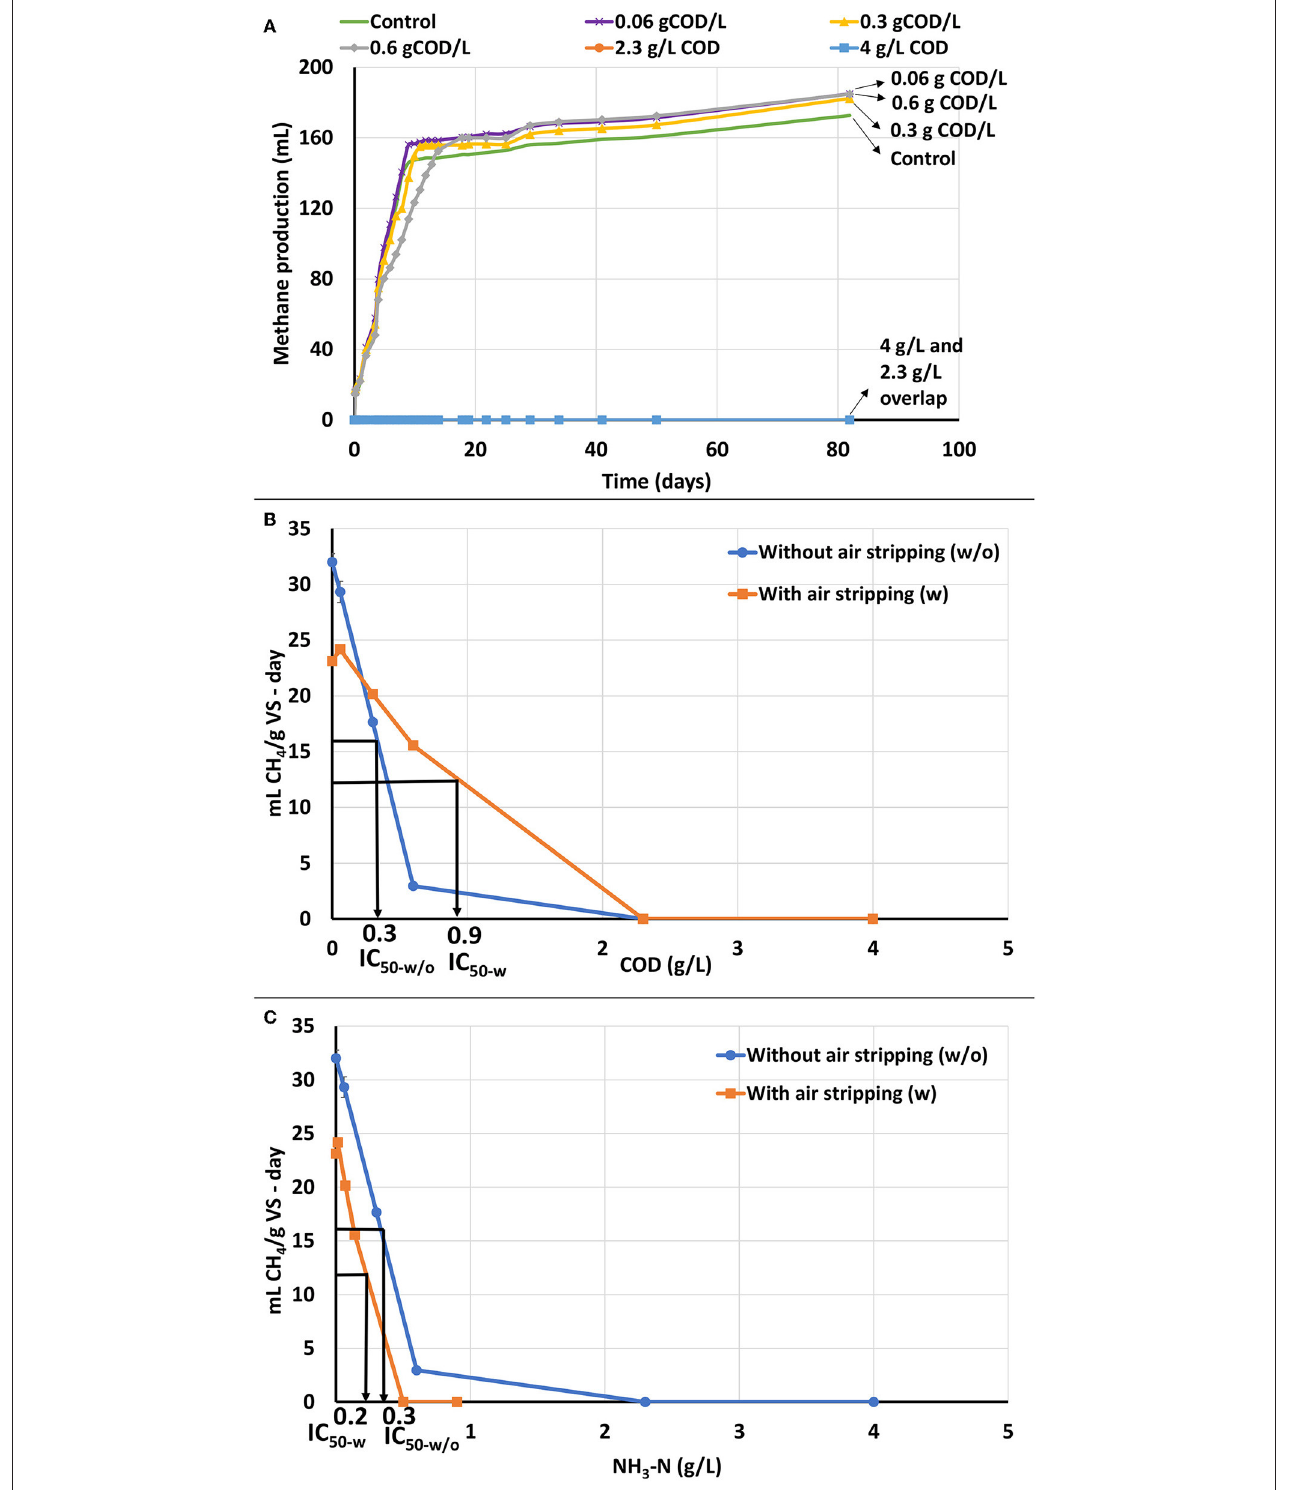
FIGURE 3 | ATA results on catalyzed APL with air stripping. Error bars represent standard deviation among duplicates. (A) Cumulative methane production of catalyzed APL with air stripping at different concentrations. (B) ATA dose-response curves based on COD for catalyzed APL with and without air stripping and comparison of IC 50 values between air-stripped and non-air-stripped catalyzed APLs. (C) ATA dose-response curves based on NH 3 -N for catalyzed APL with and without air stripping and comparison of IC 50 values between air-stripped and non-air-stripped catalyzed APLs.